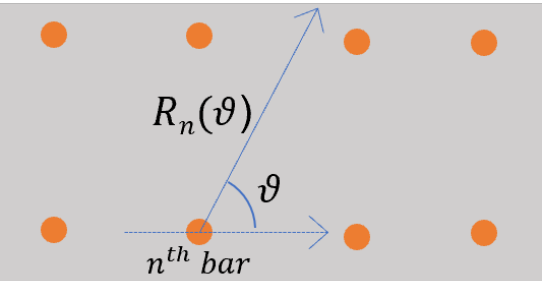
Figure 2. Reference system used to compute the integral in